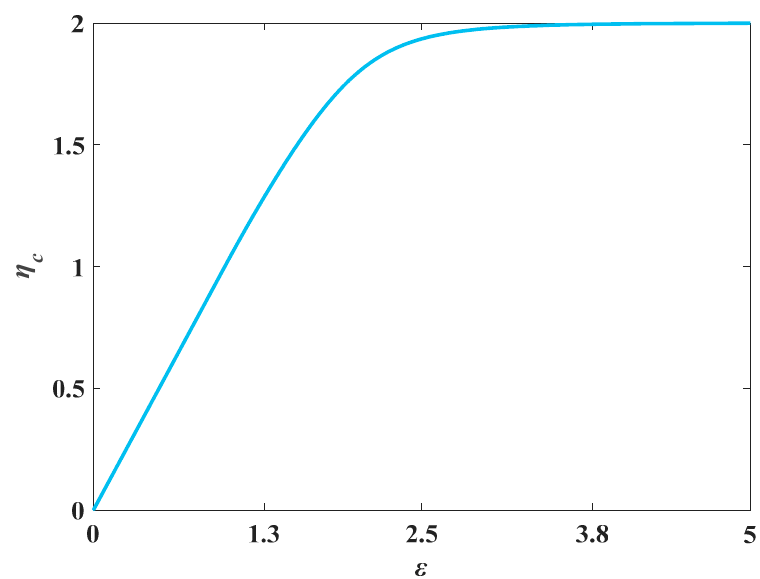
Figure 5. The relation curve between the ε and η a functions of the arched section.